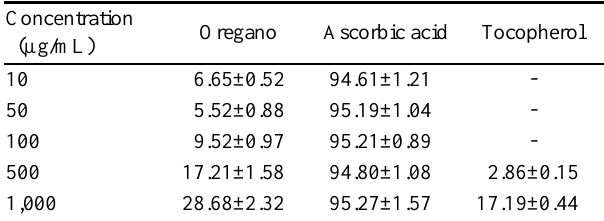
Table 3. Total phenolic and flavonoid content in water extracts of oregano Oregano extract